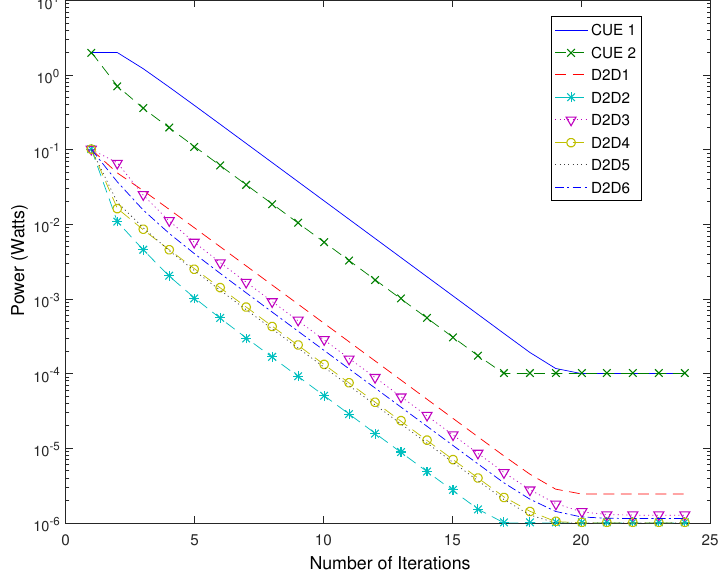
Figure 7. Transmit Power Convergence for a random